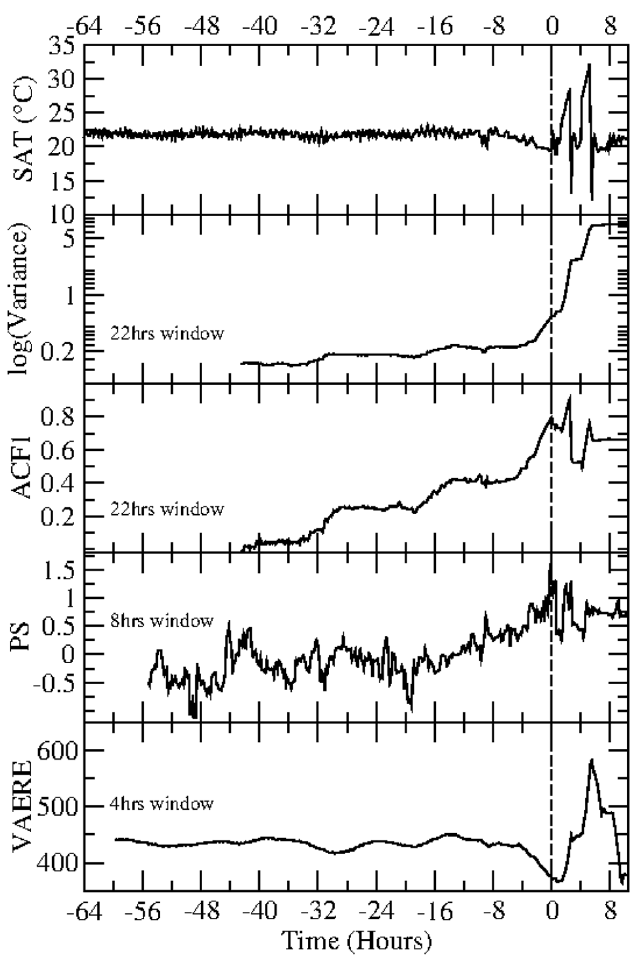
Fig. 2. Supply air temperature according to four indicators: variance, auto-correlation function, power spectrum and varia- tional autoencoder. The moment of the failure (when the supply air temperature increases anomalously for the fi rst time) is 9:30AM of the 27th of January 2019. Plot starts at 5:30 AM of the 25th of January, 64 hours prior to the failure. Variance is shown in logarithmic scale to make the increase prior to failure more visible. Window sizes used: 22 hours for variance and ACF1, 8 hours for PS and 4 hours for